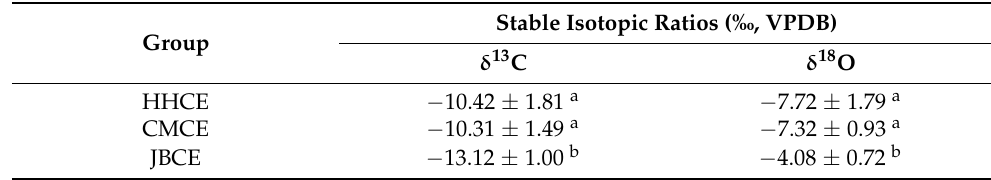
Table 3. Stable isotopic ratios in the otolith nucleus regions of Coilia nasus . Stable Isotopic Ratios (‰,